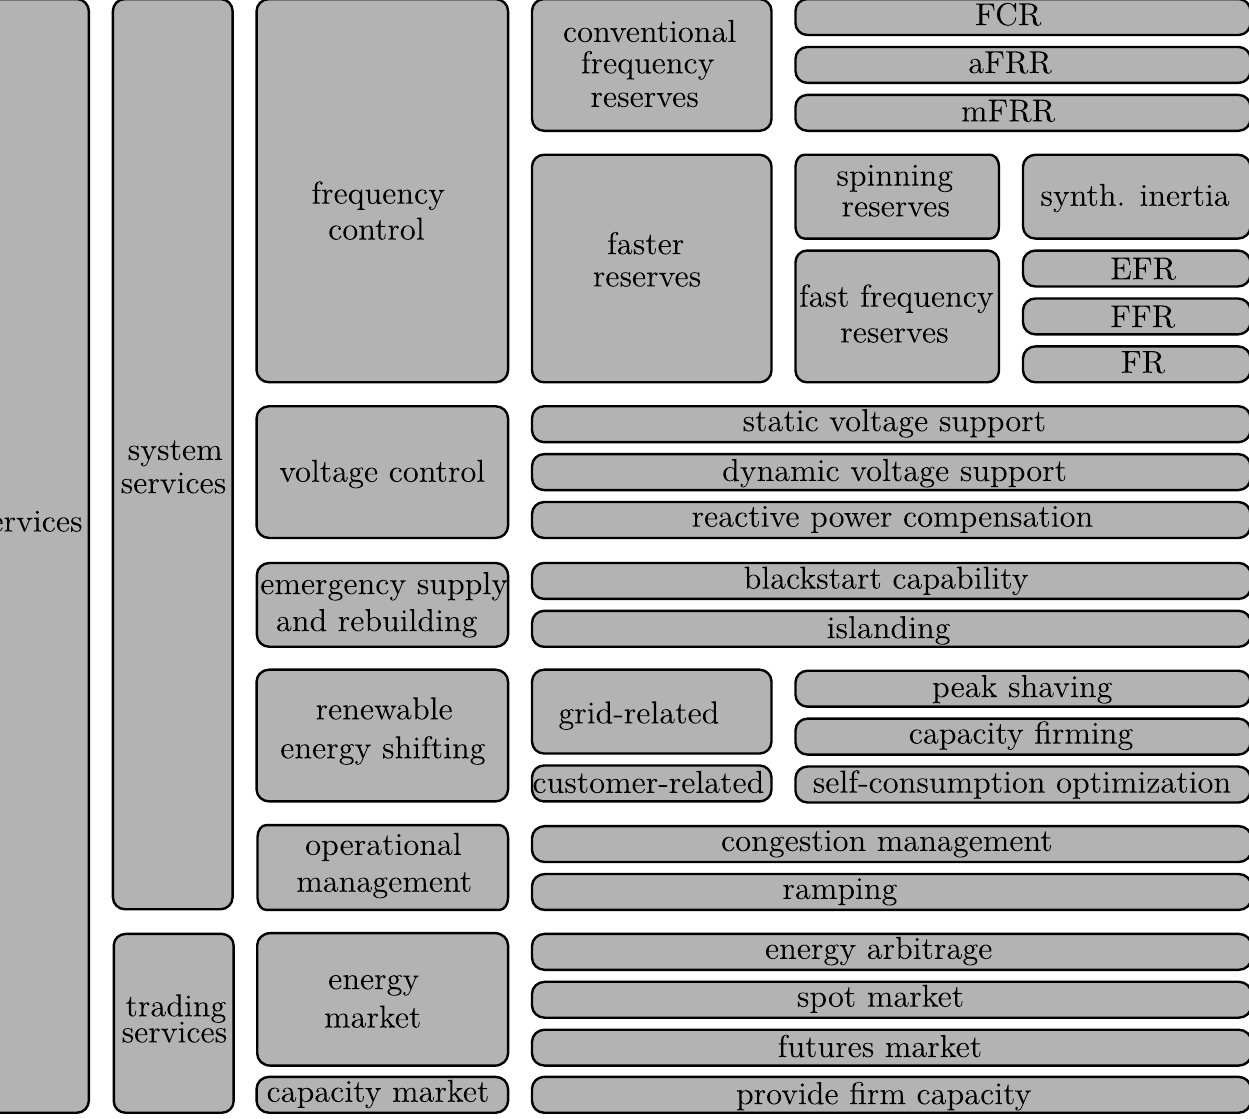
Figure 1. Categorization of services for which Battery Energy Storage Systems (BESS) are